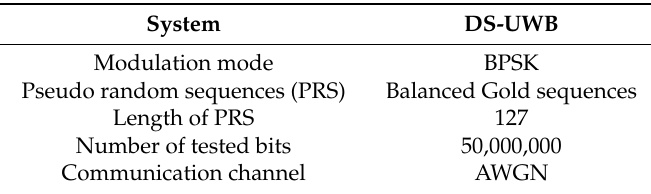
Table 1. Simulation